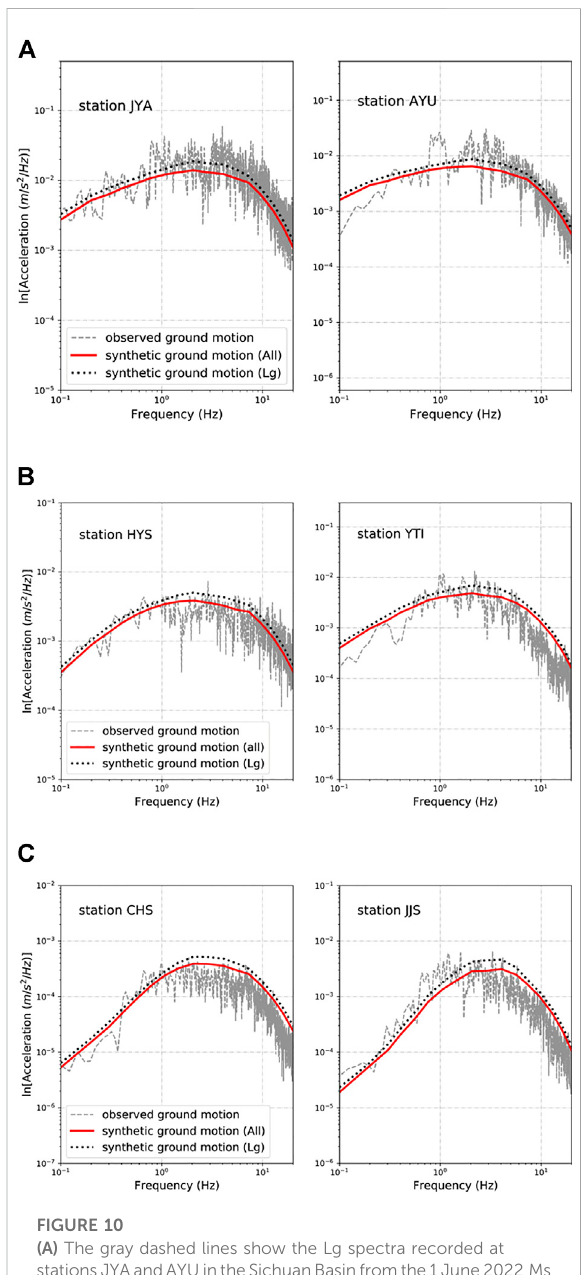
FIGURE 10 (A) The gray dashed lines show the Lg spectra recorded